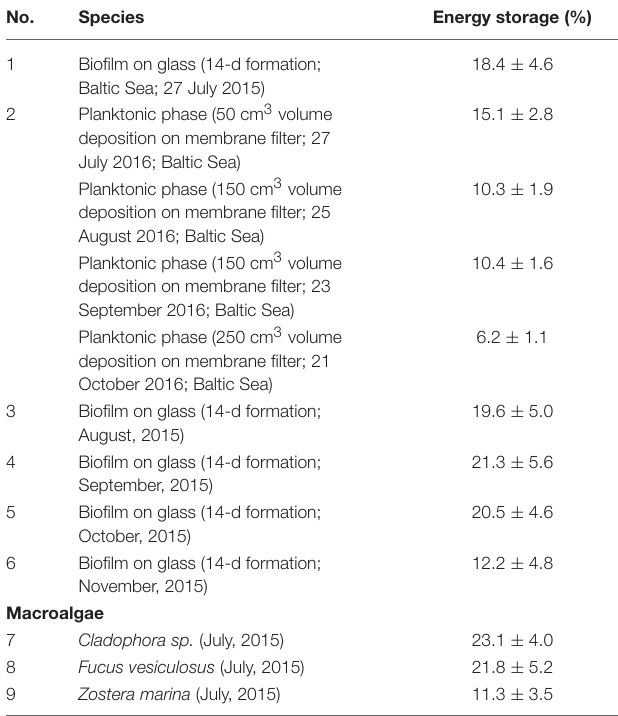
FIGURE 9 | Photoacoustic ES plot, for marine biofilm collected at a glass substratum (Baltic Sea, Gulf of Gdansk, sample age- 14 days). TABLE 3 | ES of marine photosynthetic systems studied in Baltic Sea coastal waters registered along a time period from spring to autumn seasons.